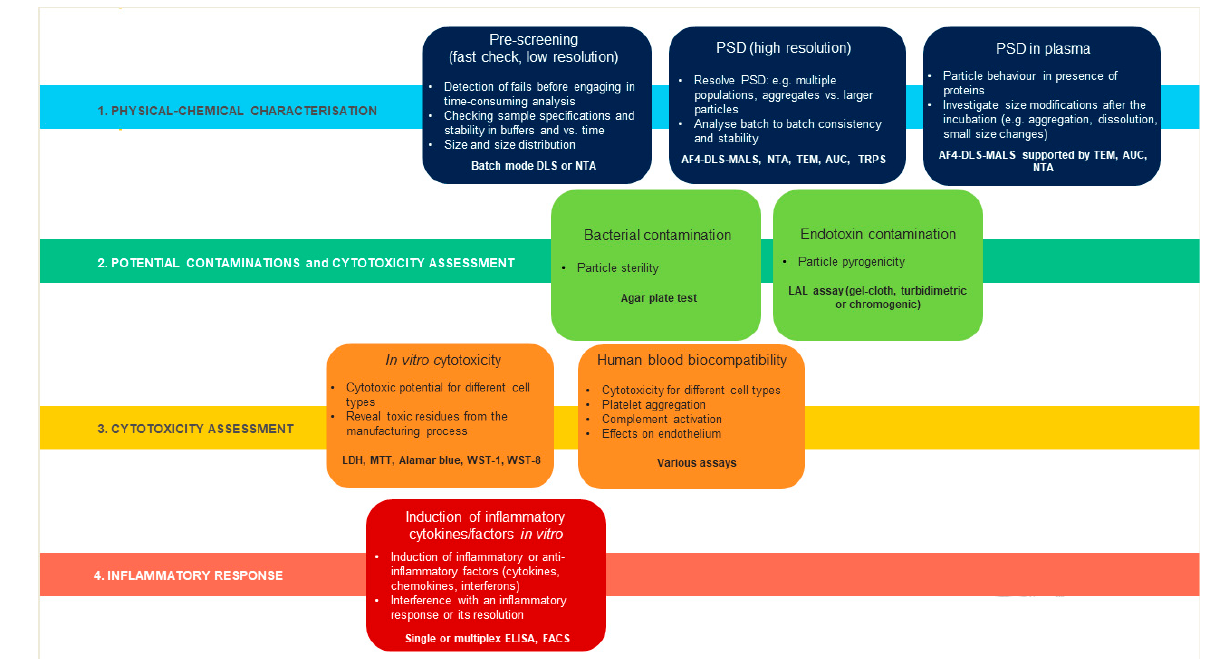
Figure 1. Each liposome was characterized for its physical-chemical properties and for potential contamination by bacteria and bacterial toxins, and eventually examined for toxicity on human cells and capacity to induce an inflammatory response. PSD, particle size distribution. Table 1. List of liposomes used in the